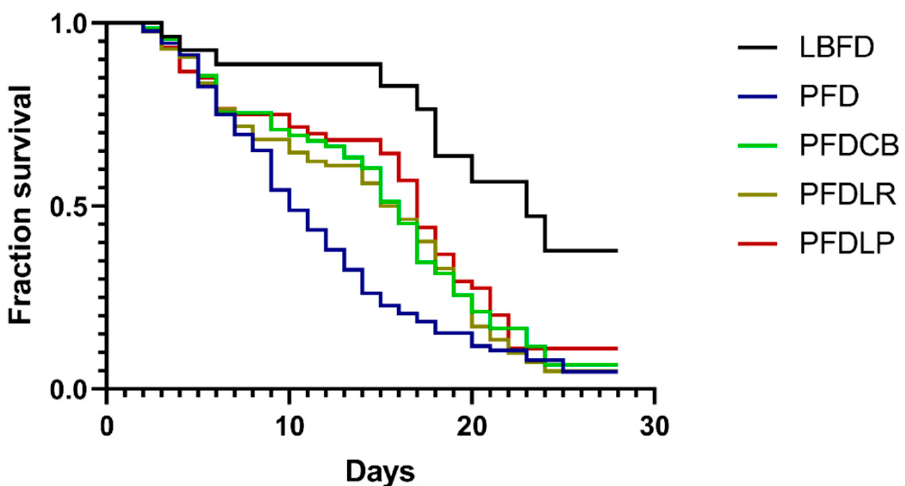
Figure 2. Kaplan Meyer’s (KM) survival analysis of mandarin fish in different feeding groups (LBFD, PFD, PFDCB, PFDLR and PFDLP) during 28 days of feeding. Abbreviations: LBFD, live bait fish feeding group; PFD, pellet-feed feeding group with probiotics free; PFDCB, pellet-feed feeding group with C. butyricum plus; PFDLR, pellet-feed feeding group with L. rhamnosus plus; PFDLP, pellet-feed feeding group with L. plantarum plus.